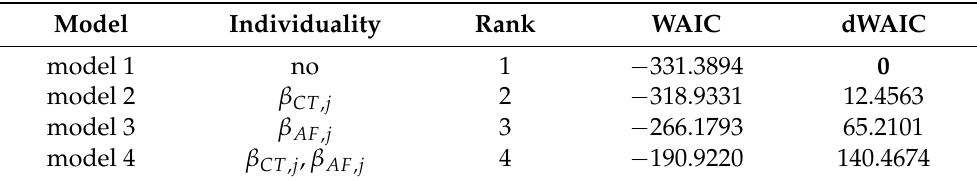
Table 2. WAICs of the statistical models. The dWAIC shows the difference from the best-performed model (model 1), which has the lowest WAIC.